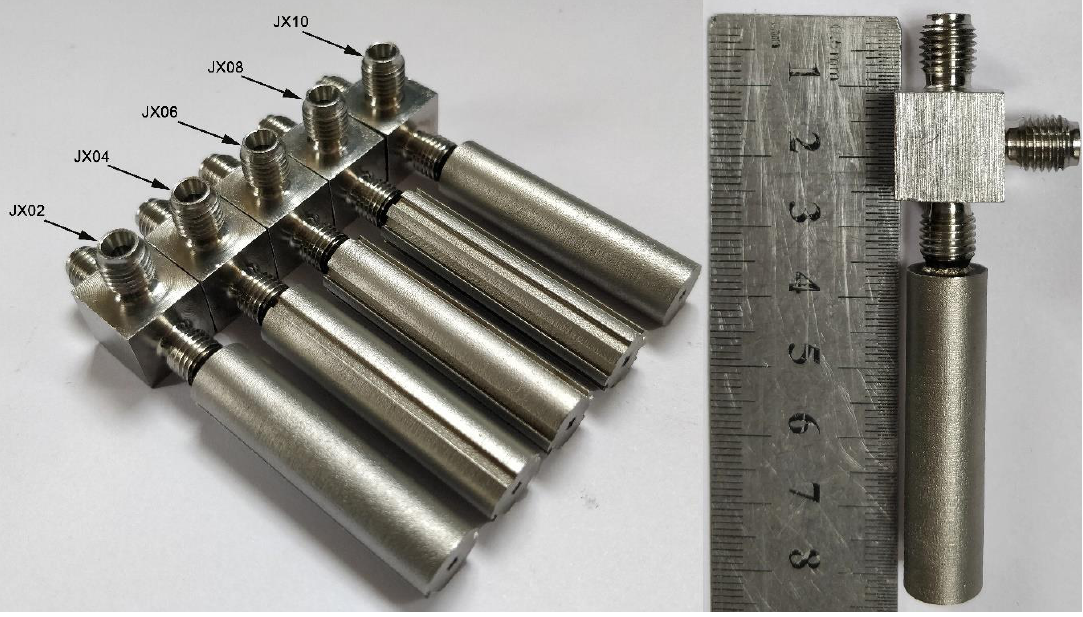
Figure 6. Welded micro reacting pipe before the micromixedness testing. Table 2. Experimental results of corrosion resistance of IN718.